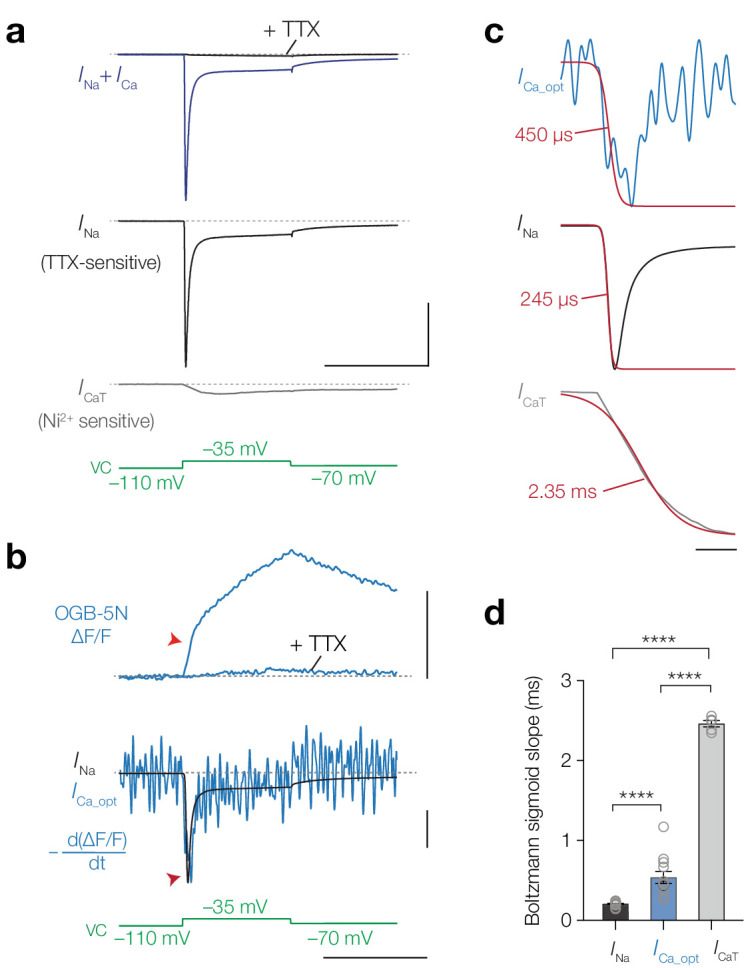
Temporal derivative of AIS [Ca2+]i mirrors the opening kinetics of NaV channels.(a) Top to bottom, total inward current in response to a voltage-clamp step to –35 mV (blue) and after application of 1 μM TTX (black), INa; the difference between the total current and the TTX-sensitive current, ICaT, obtained after application of 100 μM Ni2+, voltage clamp protocol (green). Scale bars, 10 nA and 50 ms. (b) Top to bottom: ΔF/F OGB-5N of an AIS imaged at 20 kHz before and after application of 1 μM TTX, the electrically recorded somatic INa of the same neuron overlaid with the first temporal derivative of ΔF/F (–d(ΔF/F) dt-1) representing ICa_opt, voltage clamp protocol. Optically and electrically recorded traces filtered with a 3-point binomial filter for 100 iterations. Red arrows indicate the rapid component visible in the ΔF/F and in the overlaid INa and ICa_opt. Scale bars, 20% ΔF/F, 10%–1/6.3 nA and 50 ms. (c) Top to bottom: ICa_opt, INa and ICaT fit with a Boltzmann sigmoid function (red). Slope values are indicated. Scale bar, 5 ms. (d) Population data for the slope values for INa (n = 17), ICa_opt (n = 10) and ICaT (n = 5). One-way ANOVA with Tukey’s multiple comparisons test, ****p<0.0001. Open circles represent individual cells, bars indicate the population mean ± s.e.m. Data available in Figure 6—source data 1. See also Figure 6—figure supplement 1.Figure 6—source data 1.Temporal derivative of AIS [Ca2+]i mirrors the opening kinetics of NaV channels.